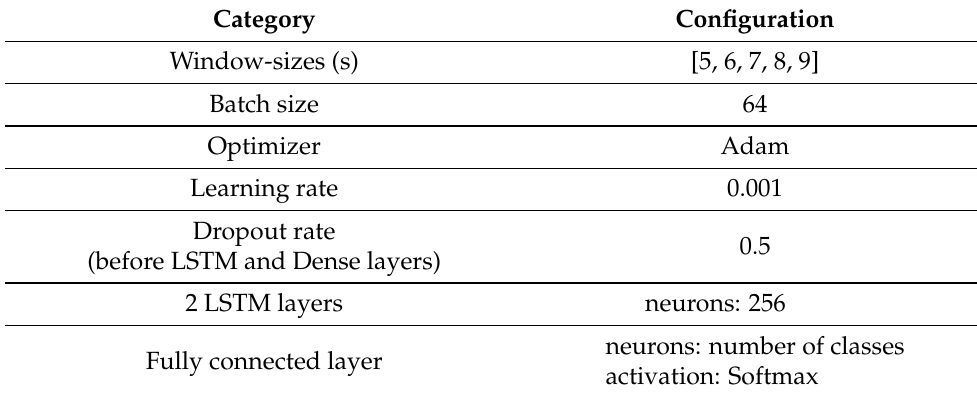
Table A2. PAMAP2 DTE-LSTM model